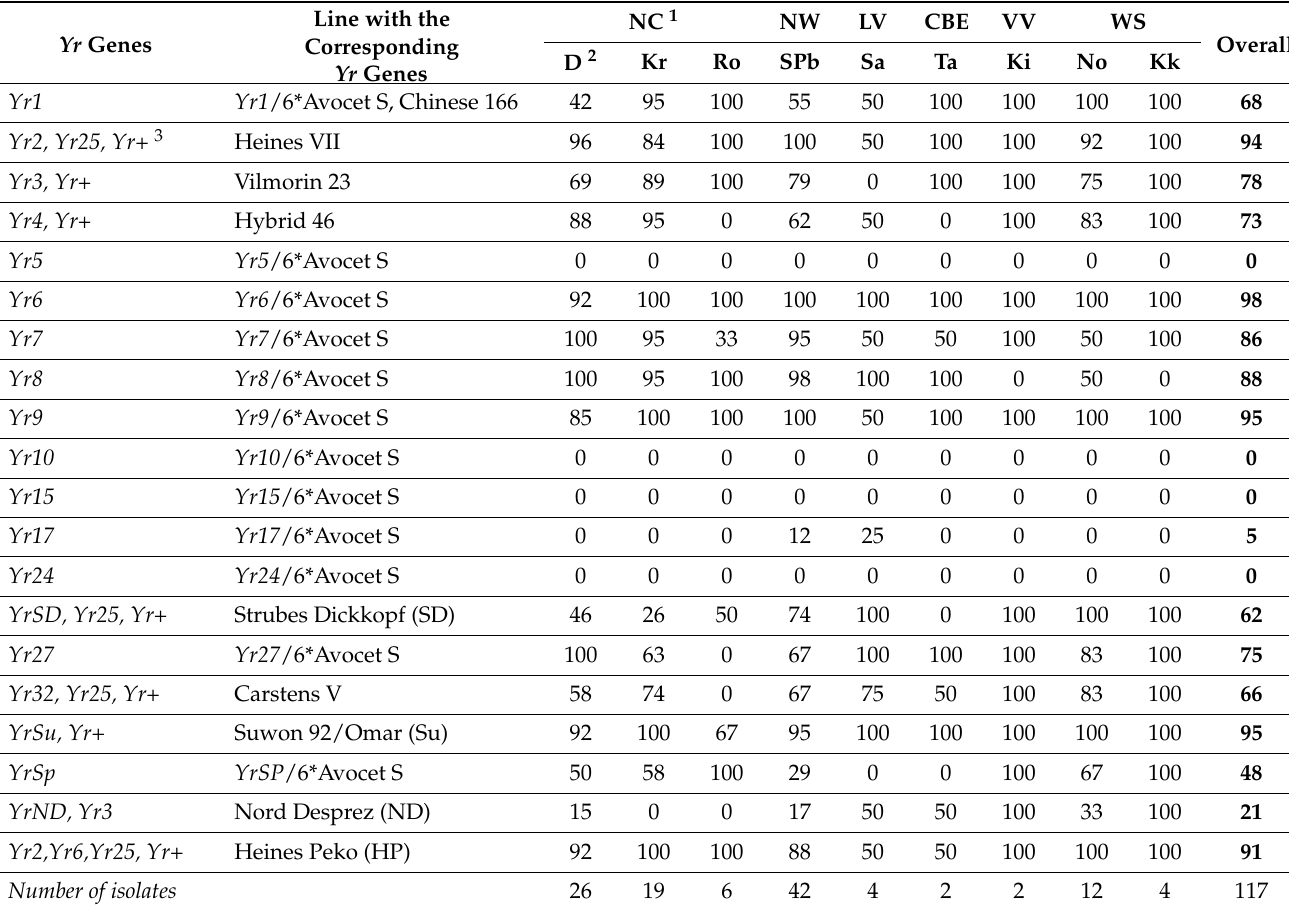
Table 2. Virulence frequency of Puccinia striiformis collections of isolates originated from common wheat in Russian